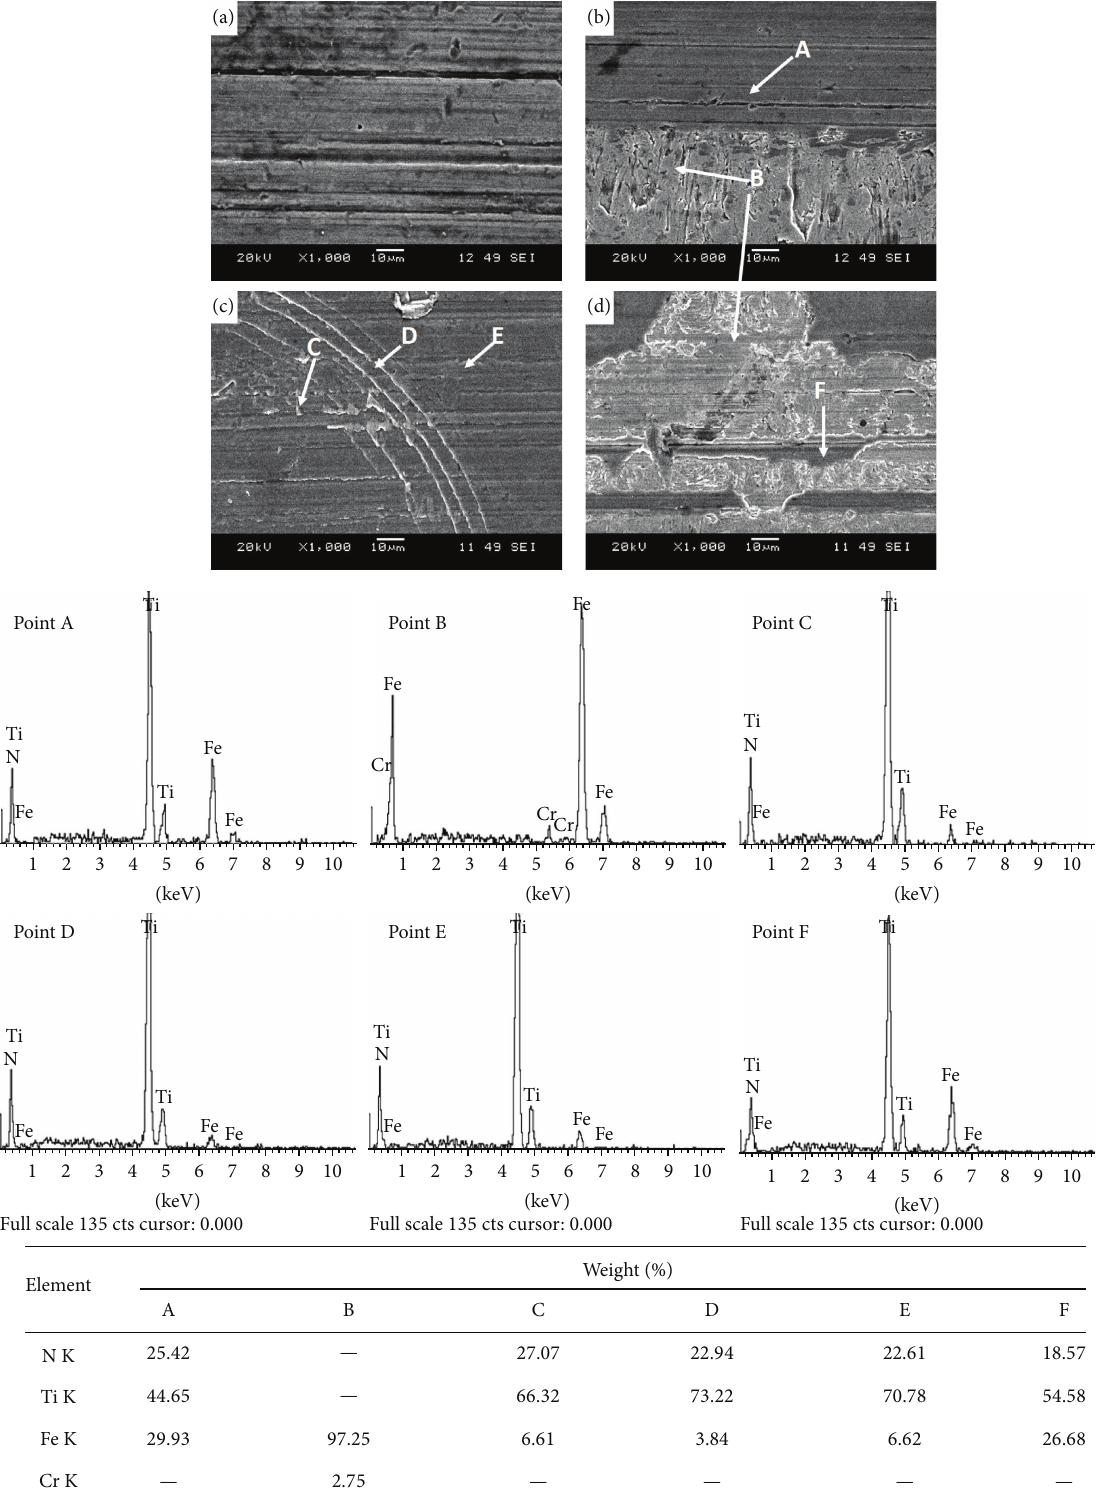
Full scale 135 cts cursor: 0.000